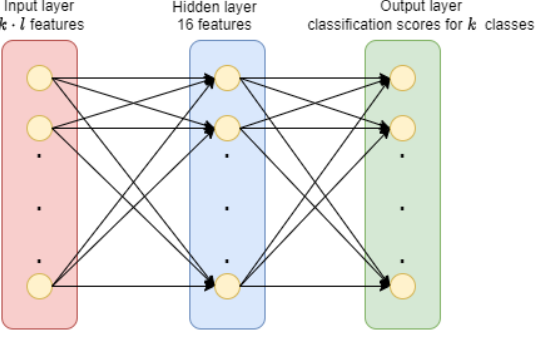
Figure 5. Architecture of MLP used for ensemble where k denotes total number of classes and l denotes total number of